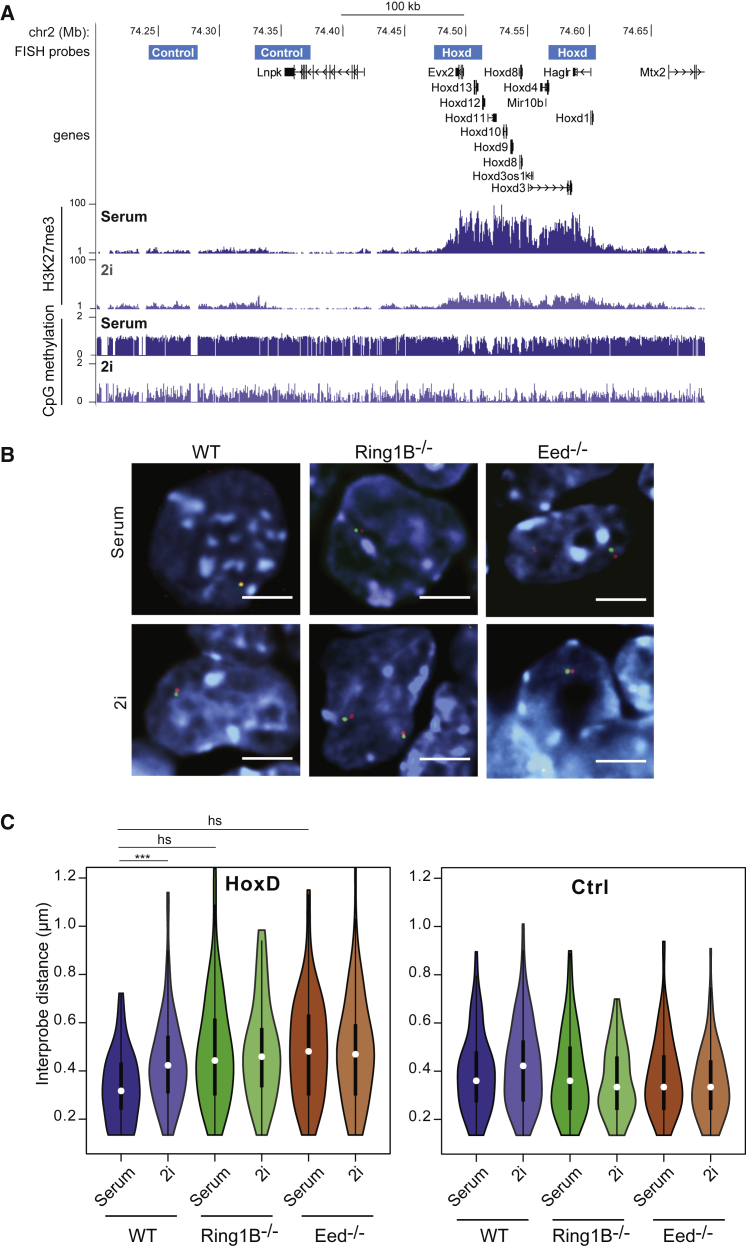
Loss of Chromatin Compaction at Polycomb Target Loci in 2i(A) UCSC genome browser tracks (mm9 assembly) showing the location (Mb) on chromosome 2 of FISH probes used to measure compaction across the HoxD locus, and at a control locus. Probe coordinates are given in Table S3. Below are shown the H3K27me3 ChiP-seq (Marks et al., 2012) and DNA methylation bisulphite (Habibi et al., 2013) profiles for this region of the genome in mESCs grown in serum or 2i.(B) Representative images of FISH signals (red and green) from probes (indicated in A) detecting the HoxD locus in the nuclei of WT, Ring1B−/−, and Eed−/− mESCs. DNA is counterstained with DAPI (blue). Scale bars represent 10 μm.(C) Violin plots showing the distribution of inter-probe distances (μm) for HoxD and control (Ctrl) loci in WT, Ring1B−/−, and Eed−/− cells grown in serum or 2i. The vertical line and spot within each plot indicate the interquartile range and median, respectively.∗∗∗p < 0.001; h.s., highly significant (p < 0.0001).Full details of statistical analysis are in Tables S1 and S2.